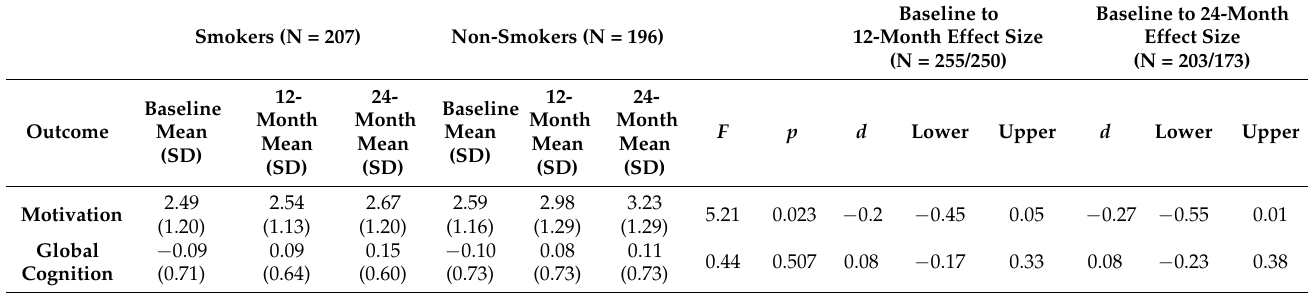
Figure 1. Mean motivation and global cognition for smokers and non-smokers at baseline, 12 months, and 24 months. Error bars represent standard error (* p < 0.05, ** p < 0.01, *** p < 0.001). ( A ) Main effects of group ( F (1, 395) = 6.44, p = 0.012) and time ( F (1, 401) = 24.24, p < 0.0001) are observed for motivation, along with a significant group-by-time interaction ( F (1 ,401) = 5.83, p = 0.016). No between group difference was observed at baseline ( t = −0.43, p = 0.669), while at 12 months, non-smokers had significantly higher motivation ( t = −2.70, p = 0.007). A statistical trend with the same pattern was observed at 24-month follow-up ( t = − 1.86, p = 0.065). Within-group differences for non-smokers were seen from baseline to 12 months ( p = 0.014) and from baseline to 24 months ( p < 0.0001). No significant within-group differences were observed for smokers (all p ’s > 0.05). ( B ) A main effect of time ( F (1, 418) = 24.24, p < 0.0001) is observed for global cognition across groups. ( C ) A main effect of time ( F (1, 217) = 9.09, p = 0.003) is observed for motivation in the schizophrenia-only analysis. A significant group-by-time interaction ( F (1, 217) = 4.48, p = 0.036) is also observed in the schizophrenia-only analysis. Table 1. Demographic and clinical characteristics of smoking and non-smoking participants at baseline. Data are reported as frequencies (with approximate percentages) or means ± standard Table 2. Means and standard deviations for global cognition and motivation in smoking and non-smoking participants at deviations. baseline, 12 months and 24 months. F -statistics and p -values for the linear mixed-effects models’ group-by-time interactions. Cohen’s d and lower/upper 95% CIs for baseline to 12 months and baseline to 24 months. N’s for effect sizes are included for motivation/global